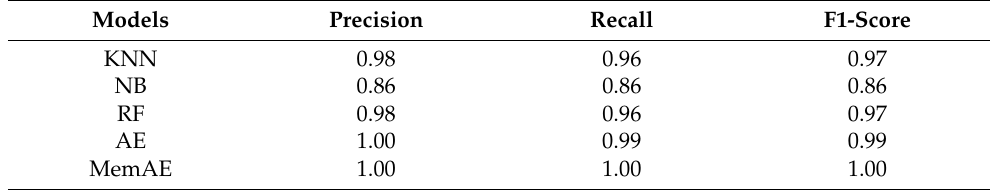
Table 9. Malicious behavior detection results by model using the preprocessed dataset (SMOTE). Models Precision